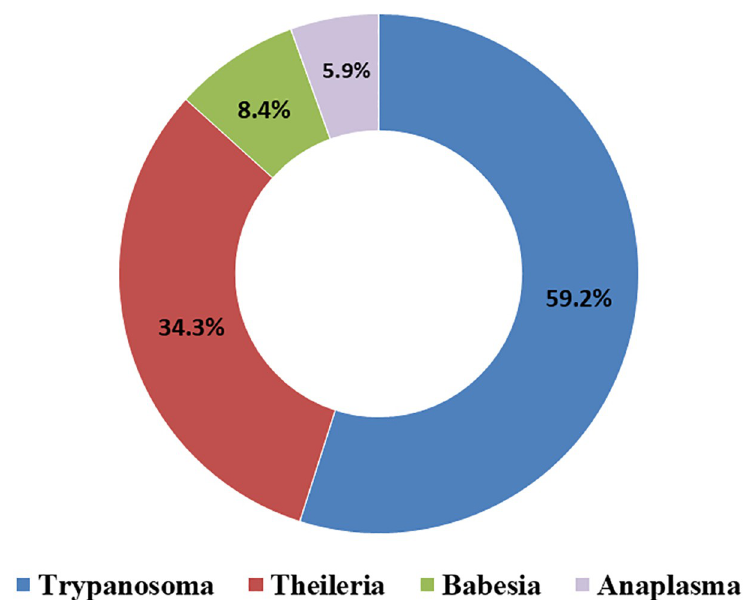
Fig 1. The proportion of blood parasites detected in blood smears from animals tested at the Veterinary Teaching Hospital | University of Mosul between Oct 30, 2017 to Dec 31, 2019.